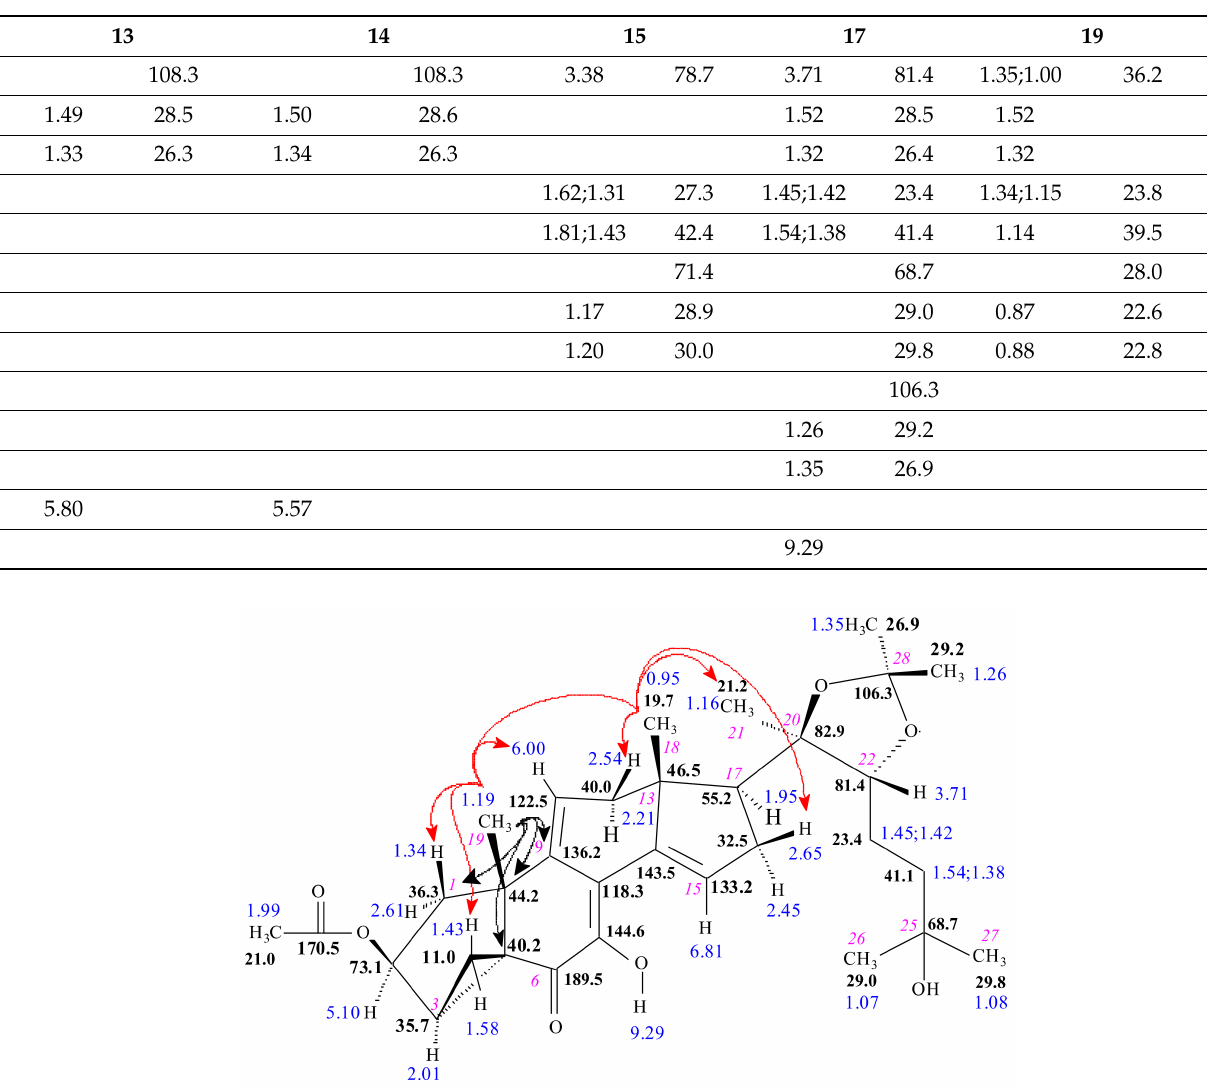
Figure 2. Stereostructure of compound 3 (C 24 H 34 O 6 ) along with its 1 H (blue numbers) and 13 C NMR (black numbers in bold) signal assignments. Cursive numbers give the atomic numbering. The α or β orientation of hydrogen atoms was determined by selROE measurements starting from H α -2 (4.53 ppm), H 3 -18 (0.62 ppm), and H 3 -19 (1.02 ppm), and red arrows show spatial proximities proven this way.